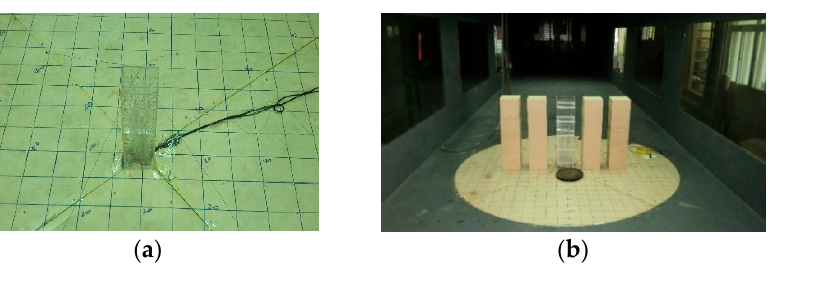
Figure 5. Photos of the wind tunnel test. ( a ) Small single model; ( b ) Test condition 5a of the medium model; ( c ) Test condition 7a of the medium model.